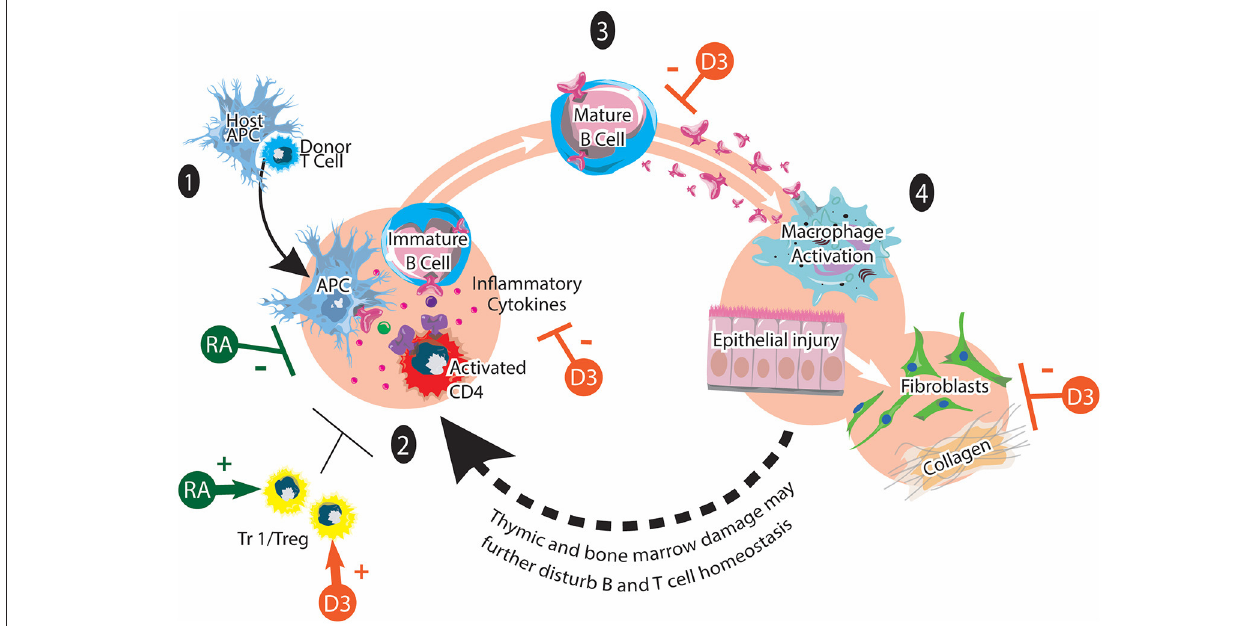
FIGURE 2 | Chronic GVHD and vitamins A and D. cGVHD pathogenesis involves: (1) Early inflammation and tissue injury. An existing inflammation and danger signals activate innate immune cells and recruits donor T cells to the tissue. (2) Dysregulated immunity with loss of tolerance. Activated CD4T cells stimulate the maturation of auto-reactive B cells. (3) Mature B cells produce various autoantibodies against host antigens. (4) Aberrant tissue repair and fibrosis via macrophages and fibroblasts. Tr1/Treg play immunomodulatory roles in chronic GVHD pathogenesis. It has been reported that synthetic retinoid (shown in green) reduces cGVHD by inhibiting Th1 and Th17 cells. It may also facilitate the generation of Tr1/Tregs. The potential effects of vitamin D on cGVHD (shown in orange) may include positive effects on Tr1/Treg function and polarization as well as inhibitory effects on proinflammatory T cell polarization, inflammatory cytokines, autoantibody secretion and collagen production. This figure is adapted from Cooke et al.